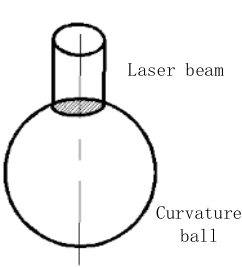
Figure 2. The cylinder passing through the sphere centre.